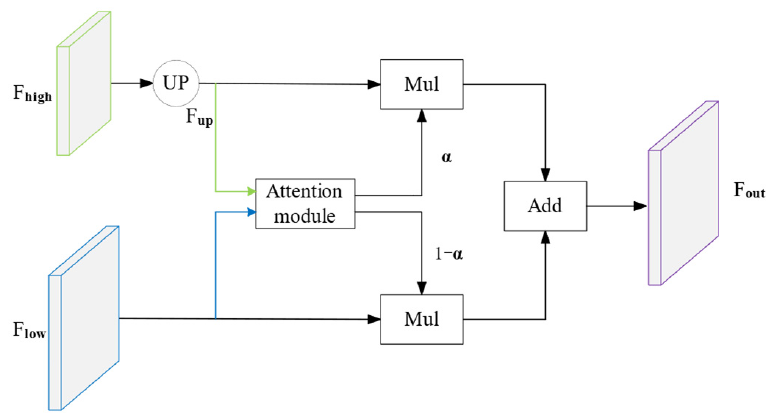
Figure 7. Unified Attention Fusion Module.